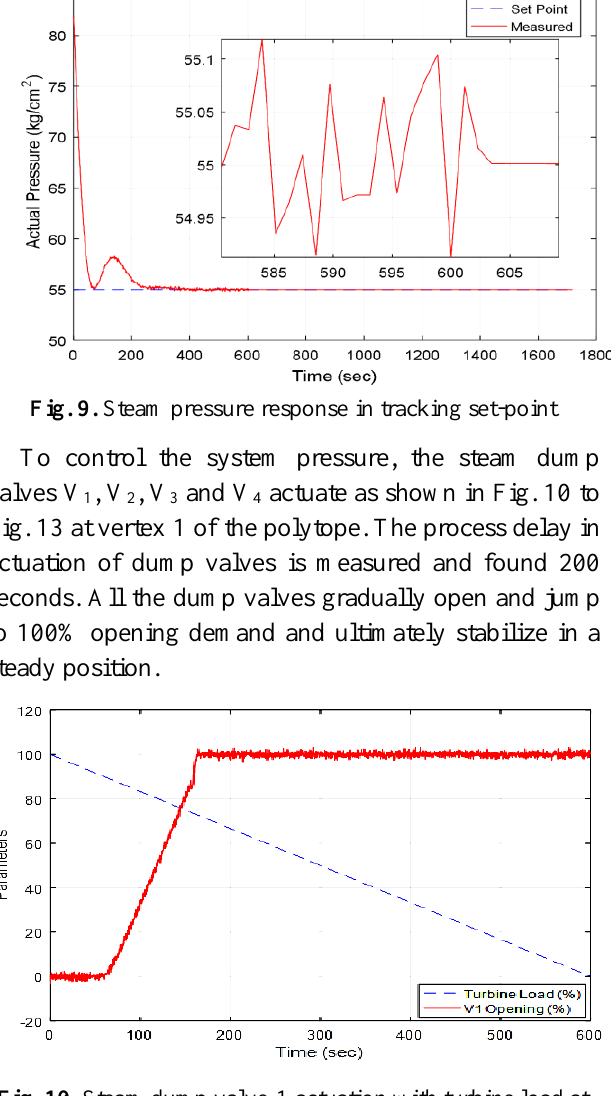
Fig. 10. Steam dump valve-1 actuation with turbine load at first vertex of polytope